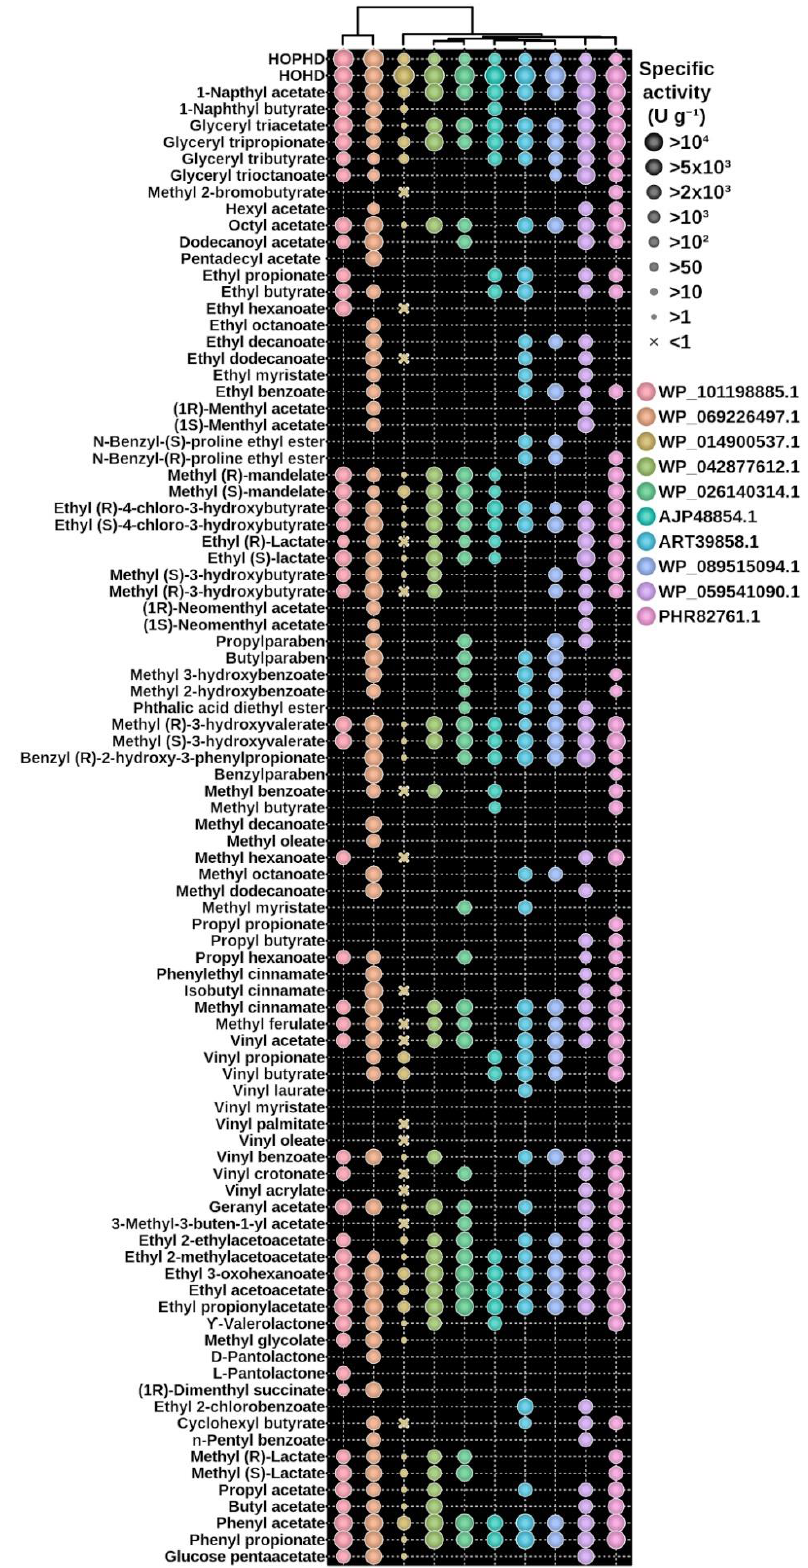
Figure 4. Substrate specificity of all ten hydrolases characterized in this study. The specific activity was measured for 2 meta-cleavage compounds (HOHD and HOPHD) and a set of 96 carboxylic esters (only those 89 found to be converted are shown). The proteins are organized based on their sequence similarity.